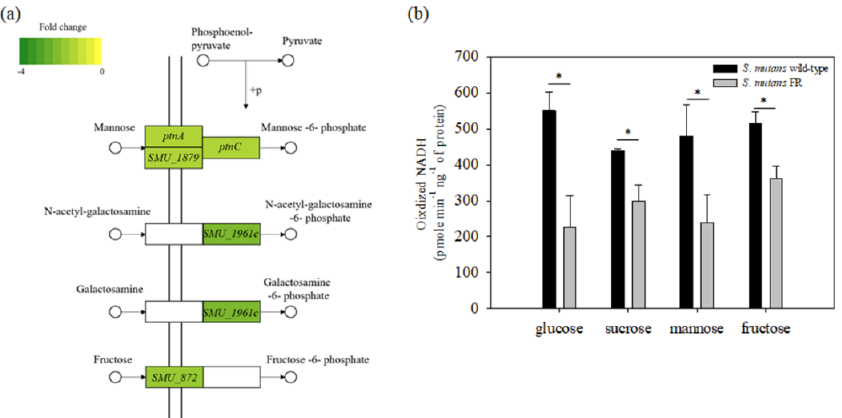
Figure 6. ( a ) KEGG diagram indicating genes that are a part of the PTS. These genes are highlighted in green, with the color intensity corresponding to their level of downregulation; ( b ) PTS transport of glucose, sucrose, mannose, or fructose was determined using permeabilized cells as described in the Materials and Methods. *, differs from the wild-type genetic background at p < 0.05. The results are expressed as mean values for three biological repeats, with error bars indicating the standard deviation.